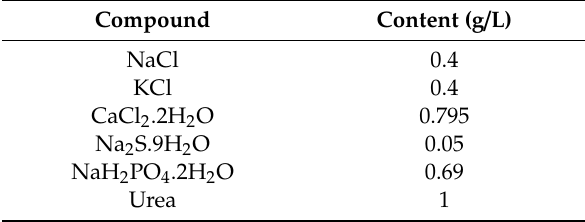
Table 1. Chemical composition of the Fusayama’s artificial saliva